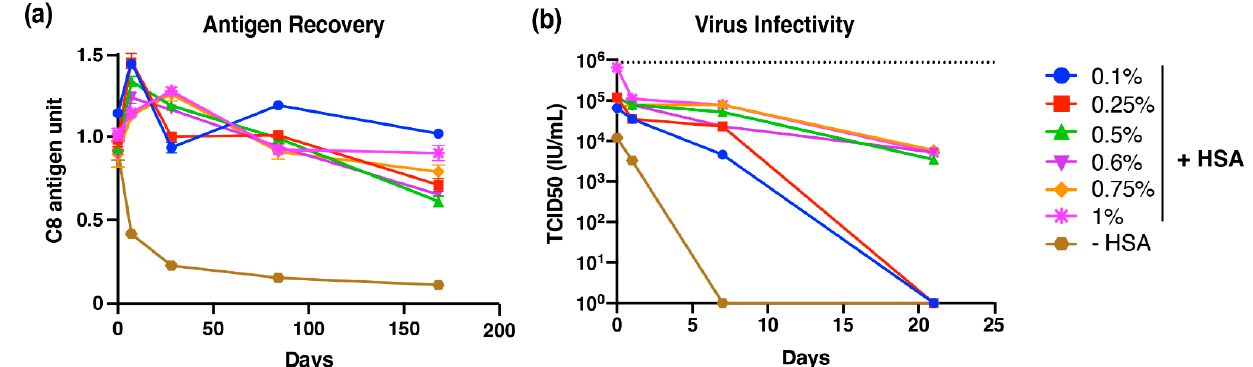
Figure 3. Long-term stability of bDENV2 formulated with different concentrations of HSA in M199 at 4 °C. ( a ) Dried bDENV2 stored at 4 °C with desiccants from 1 week to 6 months was subjected to C8-antigen-capture ELISA to analyze antigen recovery. Each condition is shown as a relative percentage recovery of bDENV2 antigen normalized to a bDENV2 stock liquid control (100%). ( b ) Dried bDENV2 stored at 4 °C with desiccants from 1 to 3 weeks was subjected to TCID50 for analysis of viral infectivity. Dotted lines represent titer (10 6 TCID50 IU/mL) of viable bDENV2 prior to storage. Error bars represents SEM from triplicate experiments.